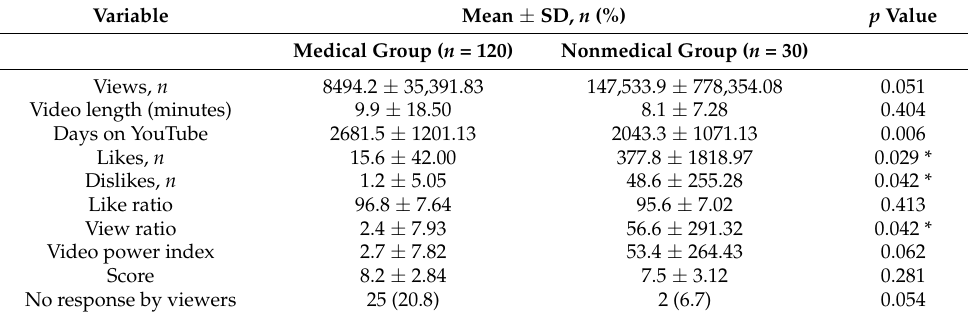
Table 4. Source comparison of the videos.